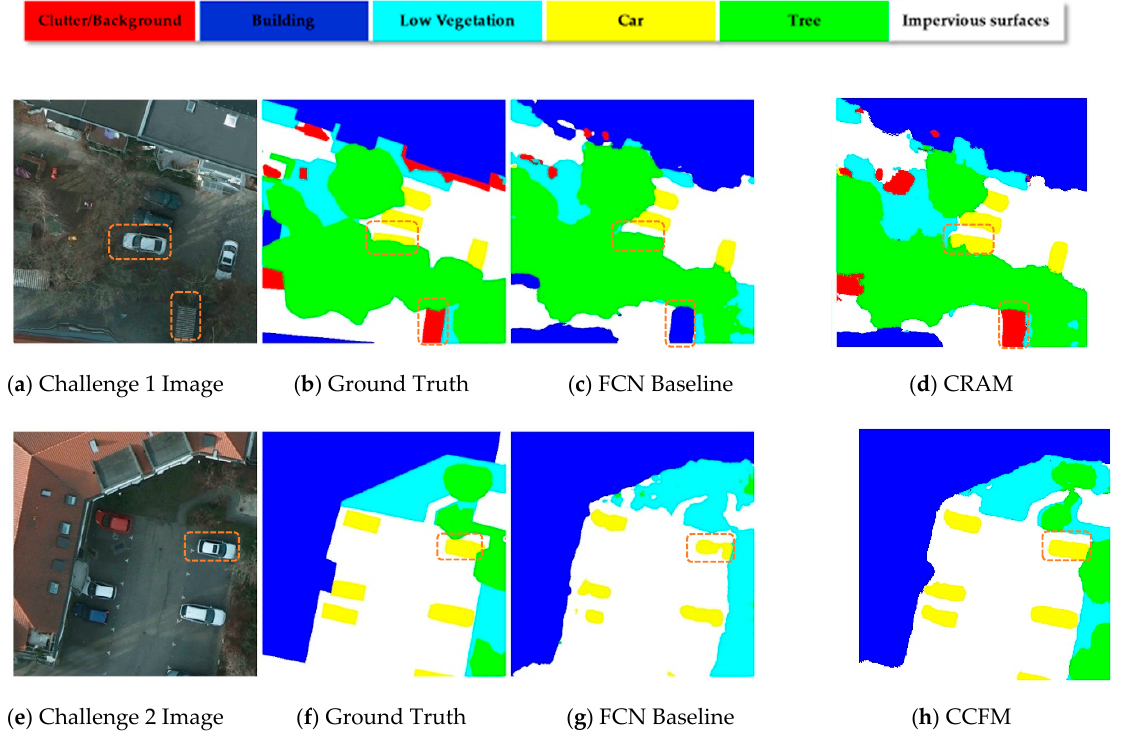
Figure 1. Illustration of challenges in the task of semantic segmentation for aerial